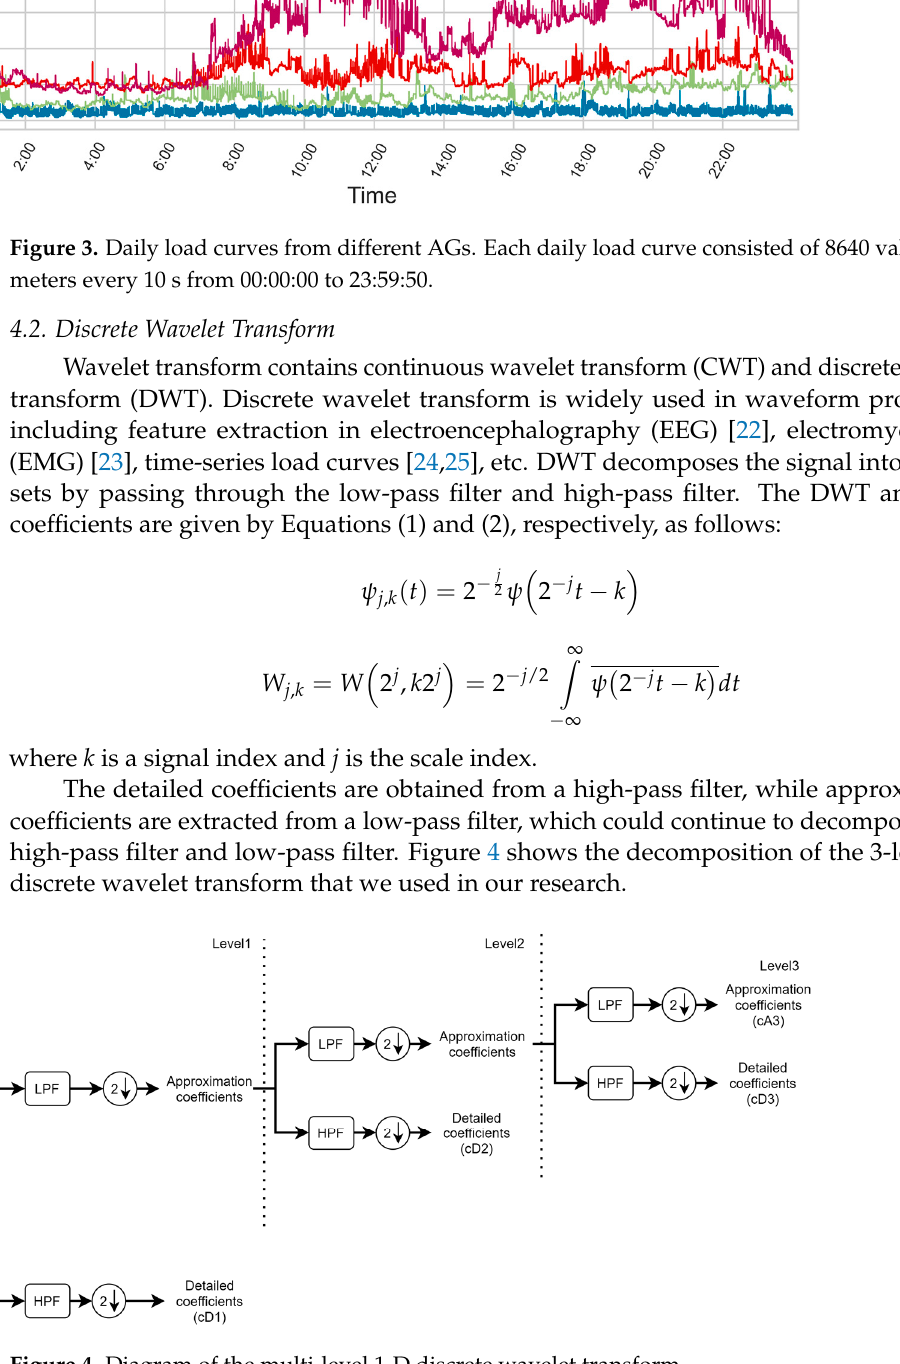
Figure 4. Diagram of the multi ‐ level 1 ‐ D discrete wavelet transform.